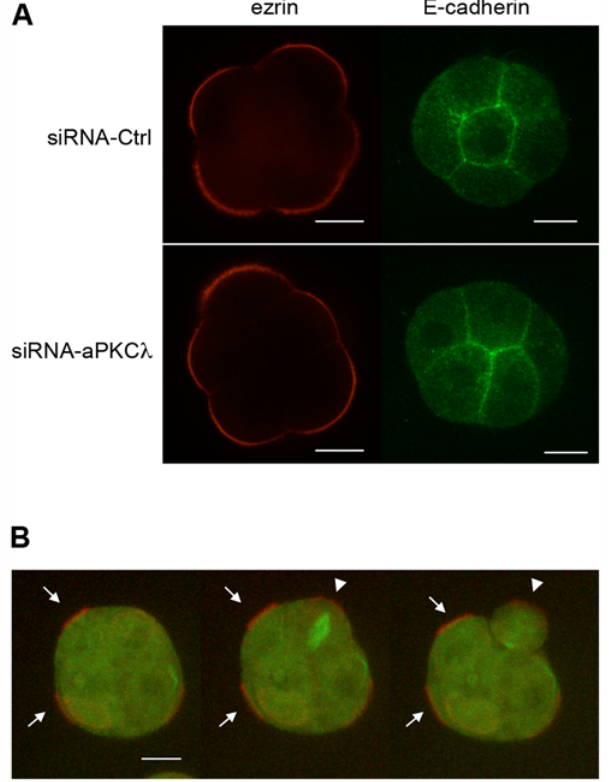
Figure 2. Establishment of apico-basal polarity at the 8-cell stage. (A): Immuno-localization of ezrin (31 embryos) and E-cadherin (23 embryos) during compaction in control siRNA (siRNA-Ctrl) or siRNA- aPKC l injected embryos. siRNA were microinjected at the 2-cell stage. Scale bars: 20 m m. (B): Spinning-disk video-microscope analysis of a siRNA-aPKC l injected embryo expressing exogenous tubulin-GFP and ezrin-mCherry during the 8- to 16-cell stage transition. Pictures were taken from the video S3 shown in the supporting information section. mRNA coding for tubulin-GFP, mRNA coding for ezrin-mCherry, and siRNA-aPKC l were microinjected at the 2-cell stage. Arrows point out apical ezrin accumulation, and arrowheads indicate stable ezrin apical staining during and after mitosis. Scale bar: 20 m m. See the supporting information section for the corresponding videos S2 and S3.